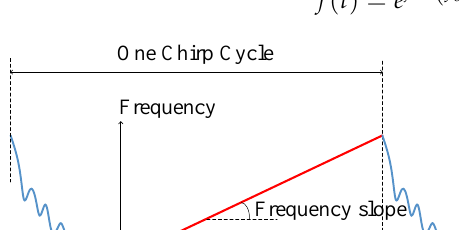
Figure 3. 3-D near-field signal